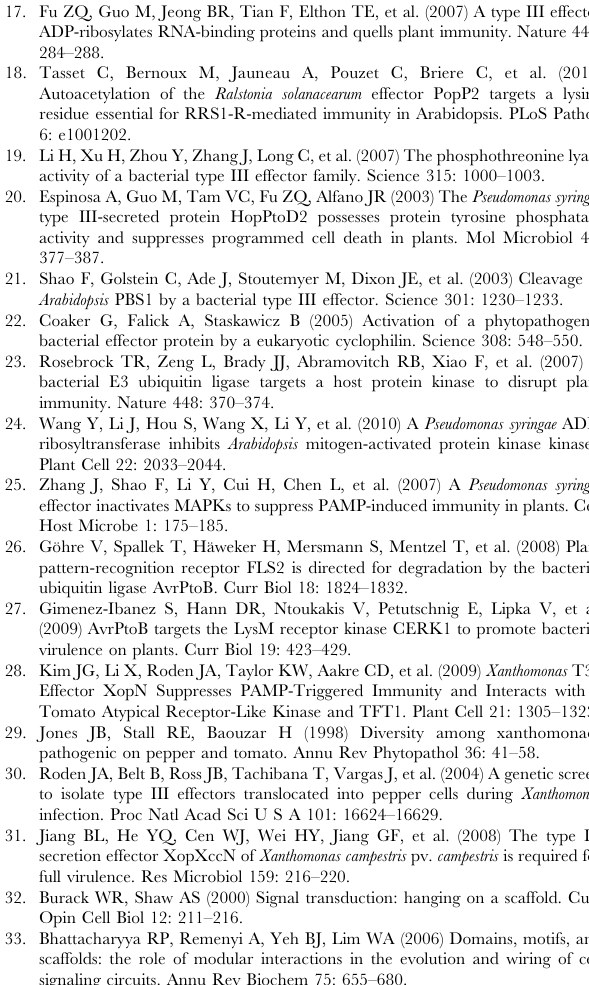
Figure S9 Protein gel blot analysis and confocal microscopy for BiFC analyses. ( A ) Protein gel blot analysis of the BiFC assay monitoring XopN/TFT1 interactions shown in Figure 8B . Anti- XopN, anti-His and anti-GFP sera were used. ( B ) BiFC assay of XopN/TARK1 interactions in N. benthamiana leaves. Leaves were hand-infiltrated with a 8 6 10 8 CFU/mL total suspension of two A.